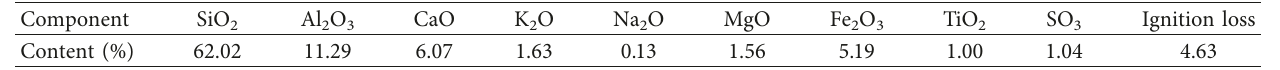
Table 2: Main chemical components of fly ash.